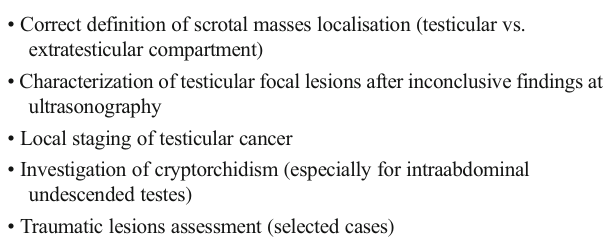
Summary of the principal indications for scrotal MRI, as derived from literature